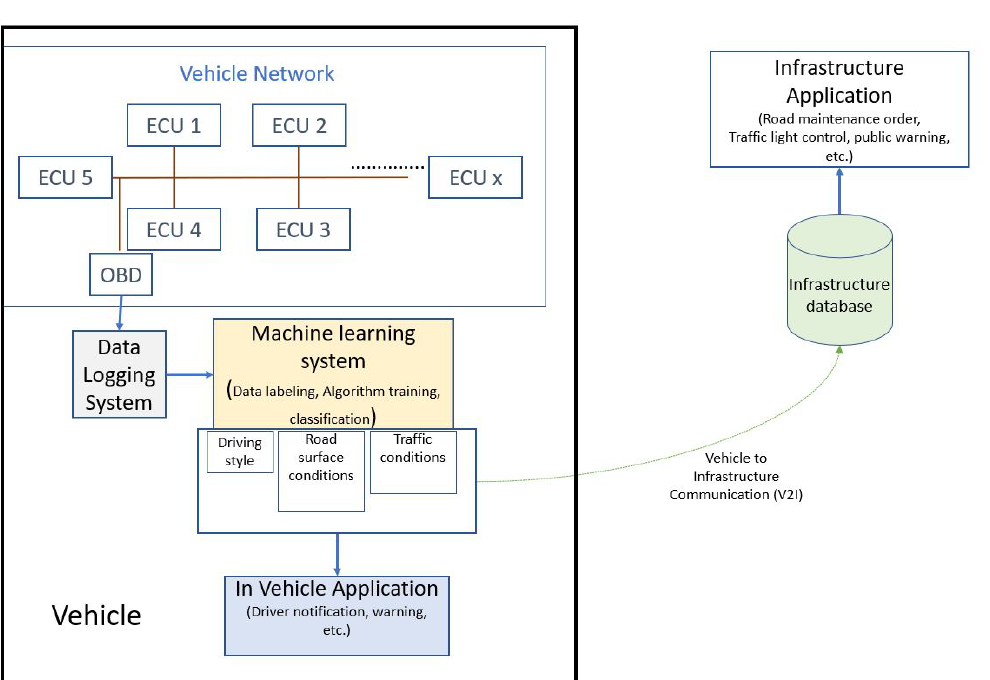
Figure 1. The figure shows the system architecture for road conditions and driving style